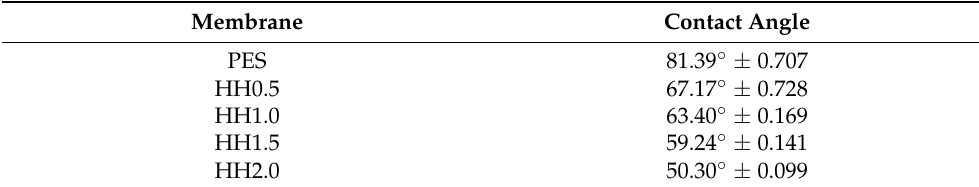
Table 3. Static contact angle of different loadings of